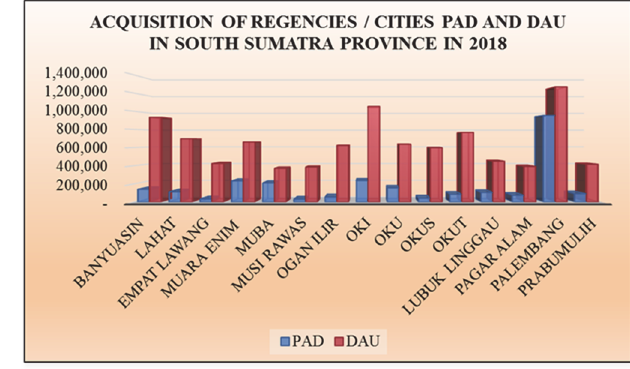
Fig. 4. Acquisition of Regencies / Cities PAD and DAU in South Sumatra Province in